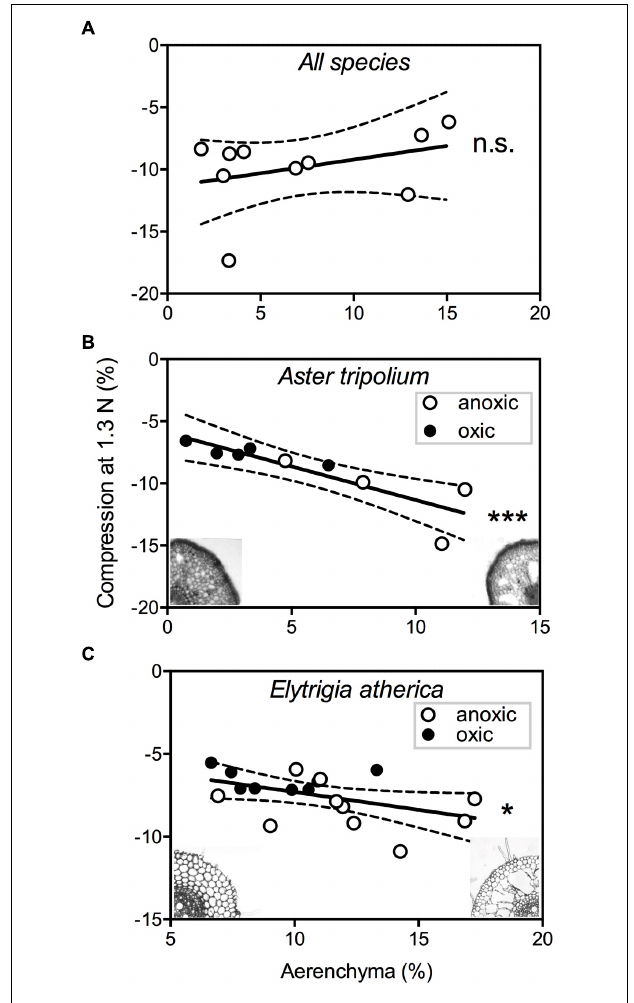
FIGURE 4 | The root compression (%) during a force of 1.3N is plotted against the amount of aerenchyma (%) for: (A) all species except Atriplex portulacoides and Salicornia europaea ( n = 10), (B) Aster tripolium ( n = 9), and (C) Elytrigia atherica ( n = 18). The closed and open circles represent roots with an oxic ( ) and anoxic ( ) treatment, respectively. The dotted lines show confidence intervals of 95%. ∗ P < 0.05; ∗∗∗ P < 0.001; ns, not (cid:32) (cid:35)